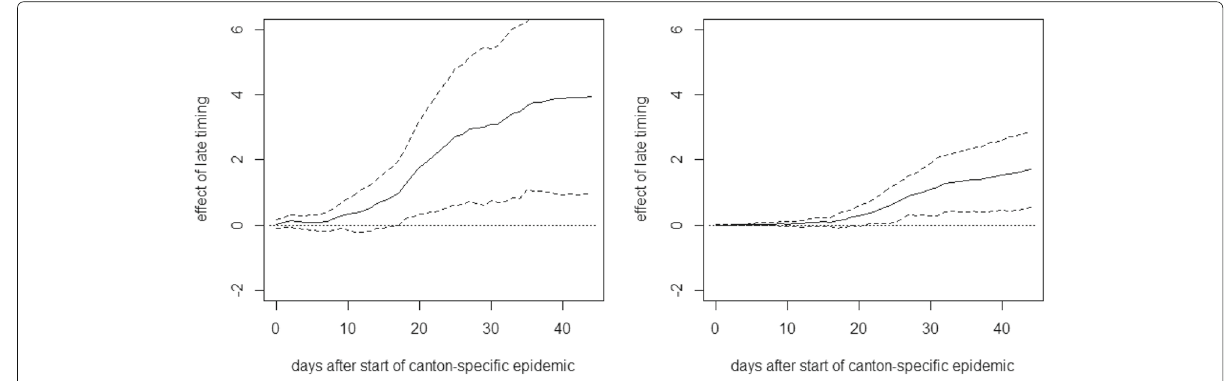
Fig. 7 Effect of late timing of measures on cumulative hospitalizations (left) and deaths (right) per 10,000